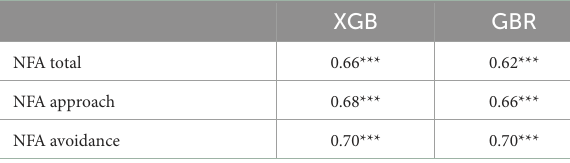
TABLE 7 The split-half reliability of